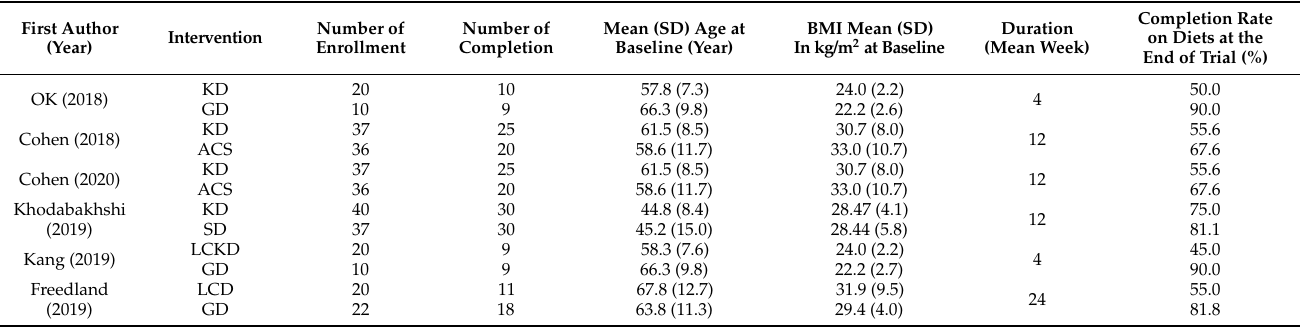
Table 4. Baseline characteristics of patient comparing intervention group and control group.